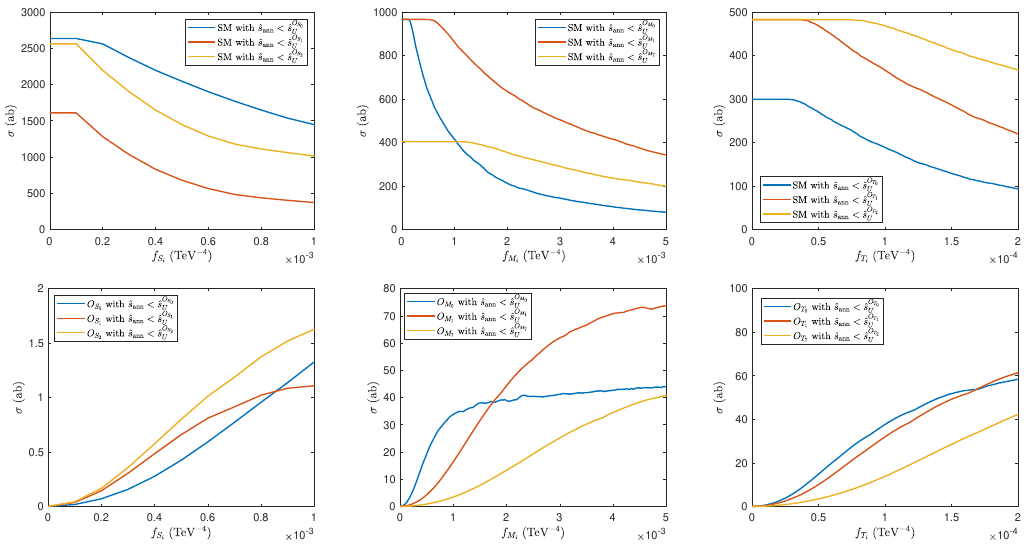
Figure 11 . The cross-sections after unitarity bounds are applied.